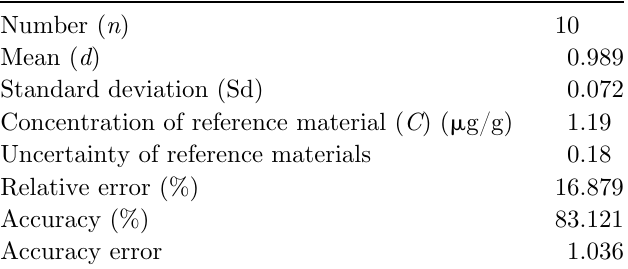
Table 5. Result of an accuracy study [17].